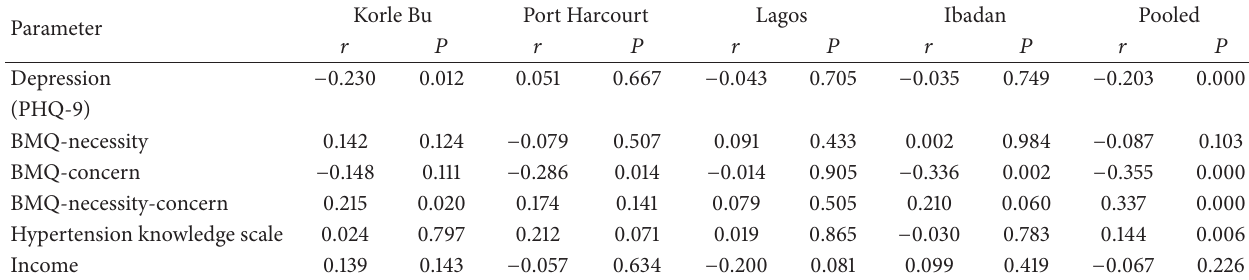
Table 2: Correlation of medication adherence (Morisky score) with depression, beliefs about medication, knowledge of hypertension, or income by site and in the pooled